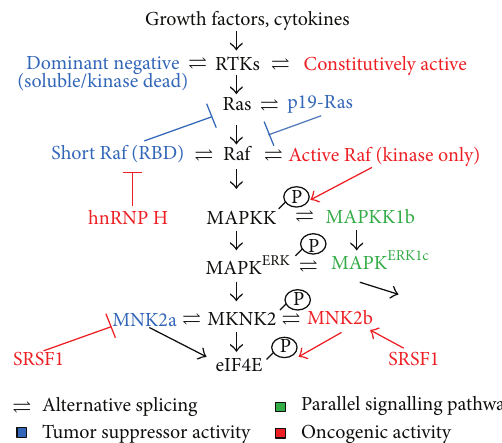
Figure 1: Alternative splicing regulation of the Ras-MAPK pathway. Growth factors and cytokines activate receptor tyrosine kinases (RTKs) which in turn lead to activation of Ras. RTKs can be alterna- tively spliced to generate soluble truncated isoforms which act in a dominant-negative manner or constitutively active isoforms which are active regardless of ligand binding. Ras can be alternatively spliced to generate p19-Ras which cannot activate its downstream effector Raf. GTP-bound p21-Ras activates A-, B-, and C-Raf which can be alternatively spliced to generate inactive dominant- negative isoforms containing only the Ras binding domain (RBD) or constitutively active isoforms containing only the kinase domain. Oncogenic splicing factor hnRNP H inhibits the production of dominant-negative A-Raf isoforms. Raf phosphorylates MAPKK (MEK) which in turn phosphorylates MAPK-ERK. MAPKK1 and ERK1 can generate MAPKK1b and ERK1c, respectively, by alter- native splicing to generate a parallel signalling pathway. MAPK- ERK can phosphorylate MNK2, which is alternatively spliced and regulated by the oncogenic splicing factor SRSF1. SRSF1 upregulates a prooncogenic Mnk2b isoform and reduces Mnk2a isoform of this kinase. Blue: tumor suppressors, red: oncogenes, and green: parallel